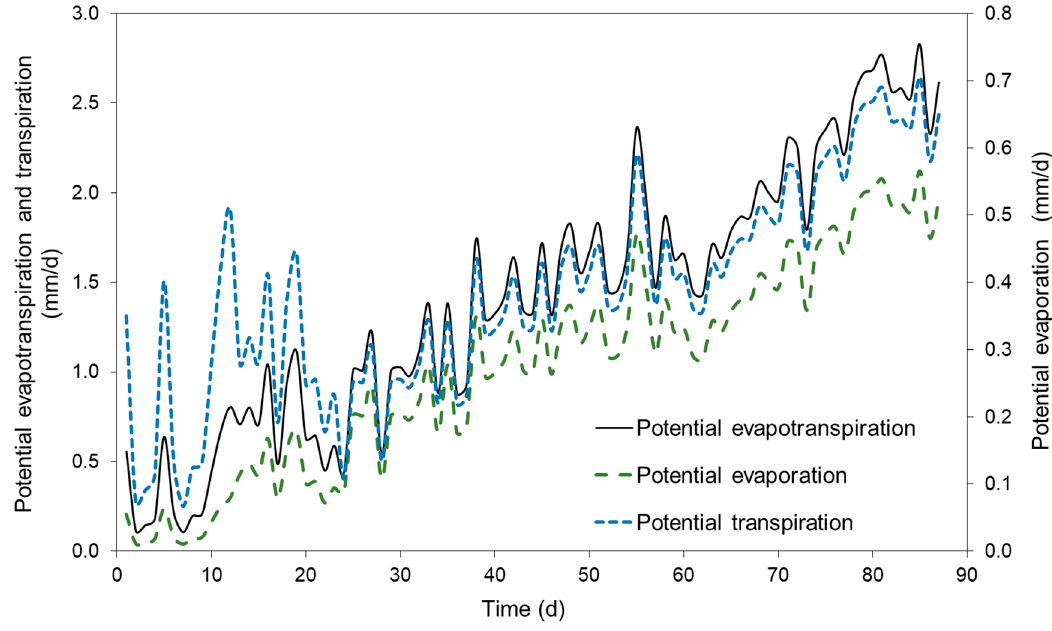
Figure 5. Calculated evaporation, transpiration, and evapotranspiration time series for the control treatment, estimated using HYDRUS 1D.